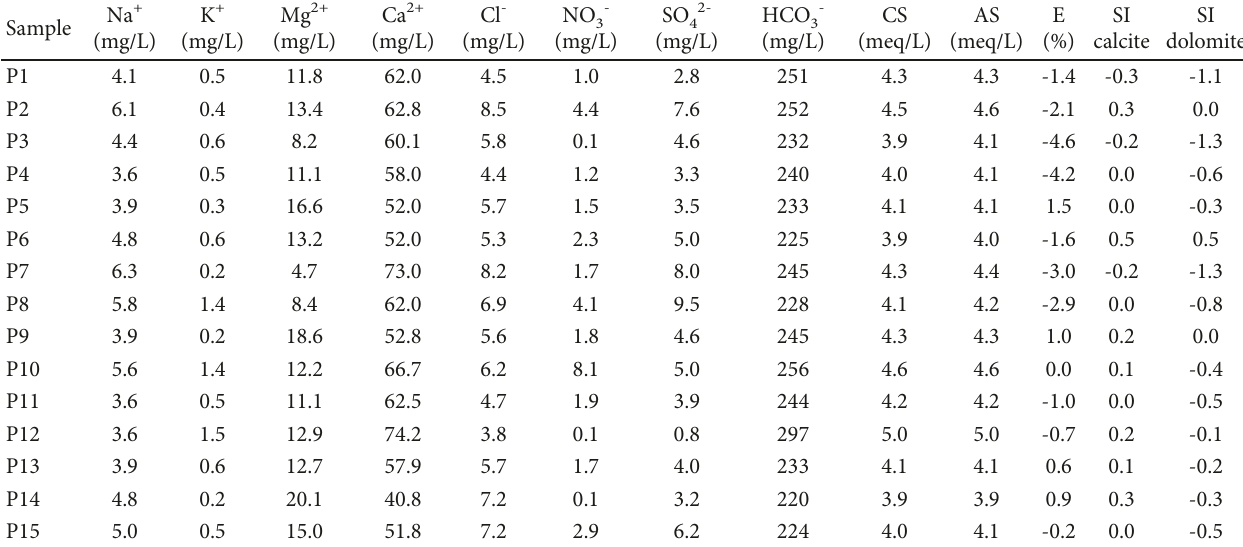
Table 2: Major element concentrations of the spring ’ s groundwater sampled in the study